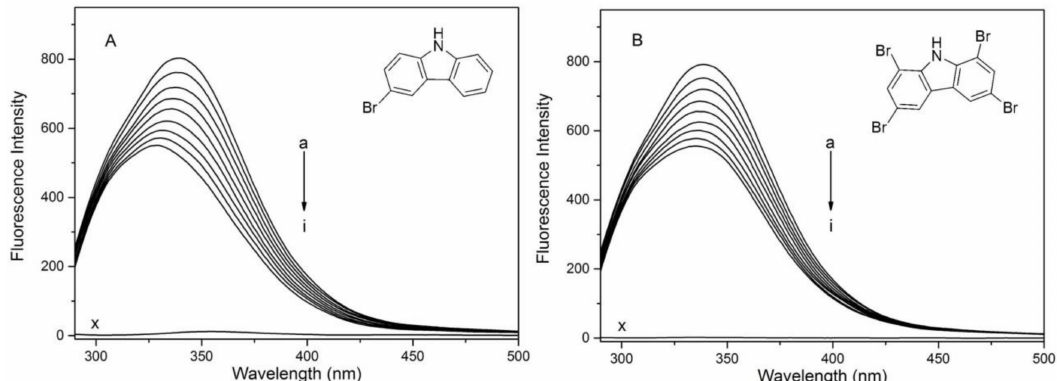
Figure 1. Fluorescence quenching spectra of human serum albumin (HSA) in the presence of different concentrations of 1,3,6,8-tetrabromocarbazole and 3-bromocarbazole. ( A ): HSA-3-bromocarbazole; ( B ): 1,3,6,8-tetrabromocarbazole; λ ex = 280 nm. C HSA = 2 × 10 − 6 M, x: Only 1,3,6,8-tetrabromocarbazole and 3-bromocarbazole concentrations; (a–i) 1,3,6,8-tetrabromocarbazole or 3-bromocarbazole concentrations were 0, 0.1, 0.2, 0.3, 0.4, 0.5, 0.6, 0.7 and 0.8 × 10 − 6 M, respectively.